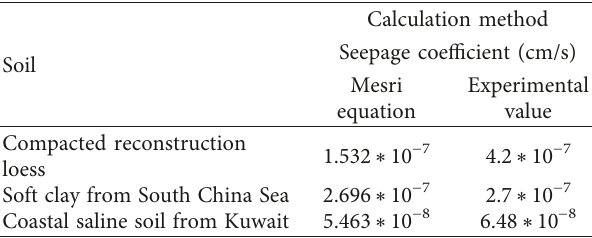
Table 9: Seepage coefficients of clay based on the Mesri